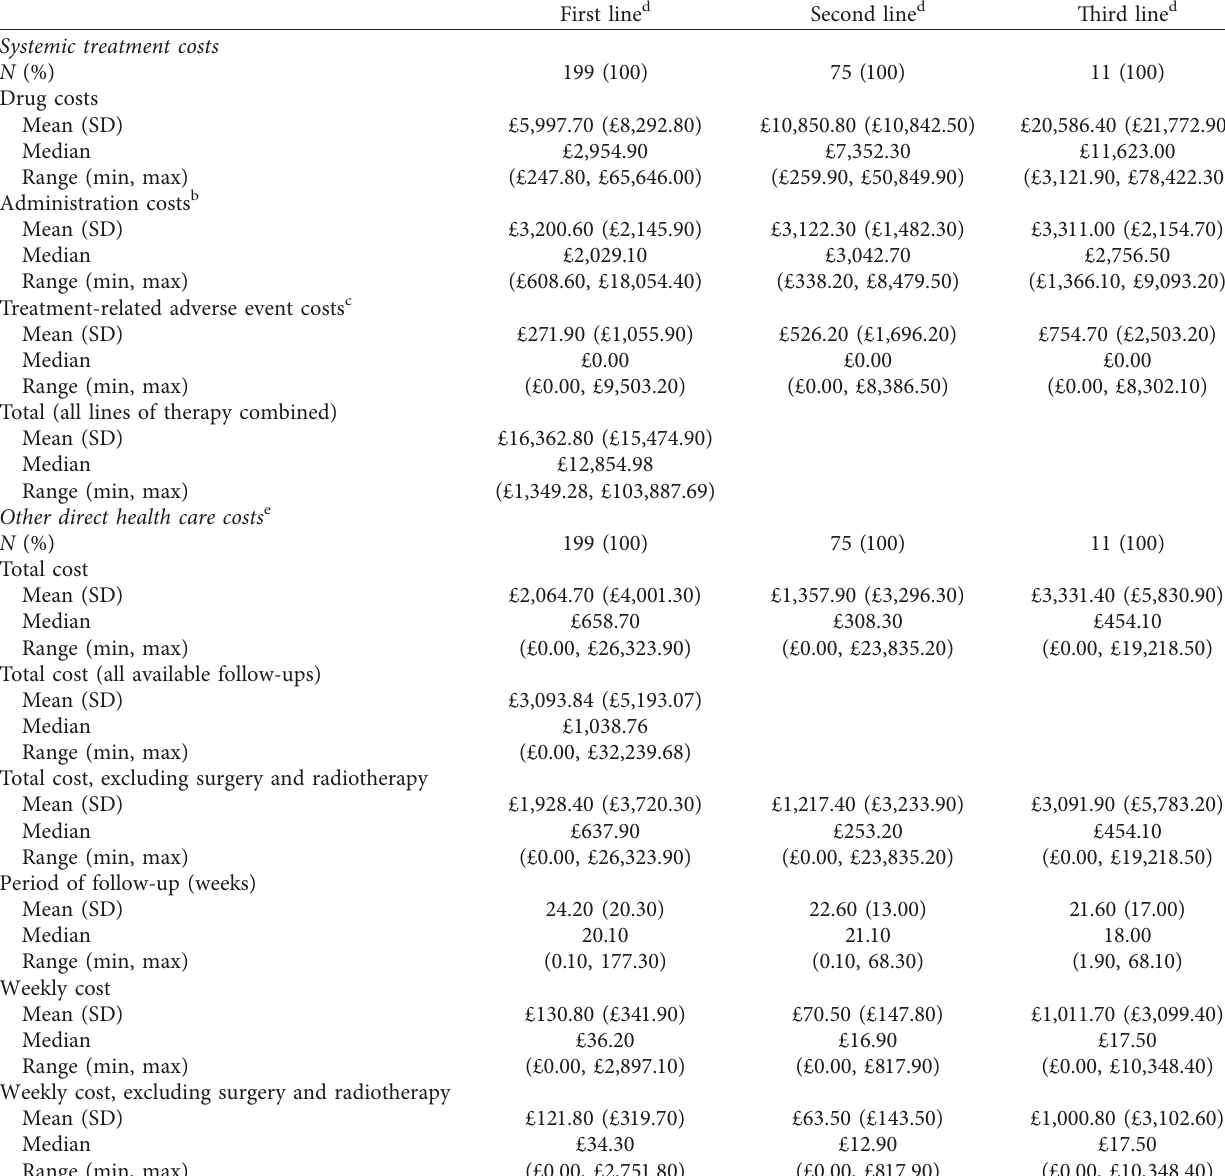
Table 4: Estimated health care costs related to treatment of advanced STS a in the United Kingdom ( n � 199). First line